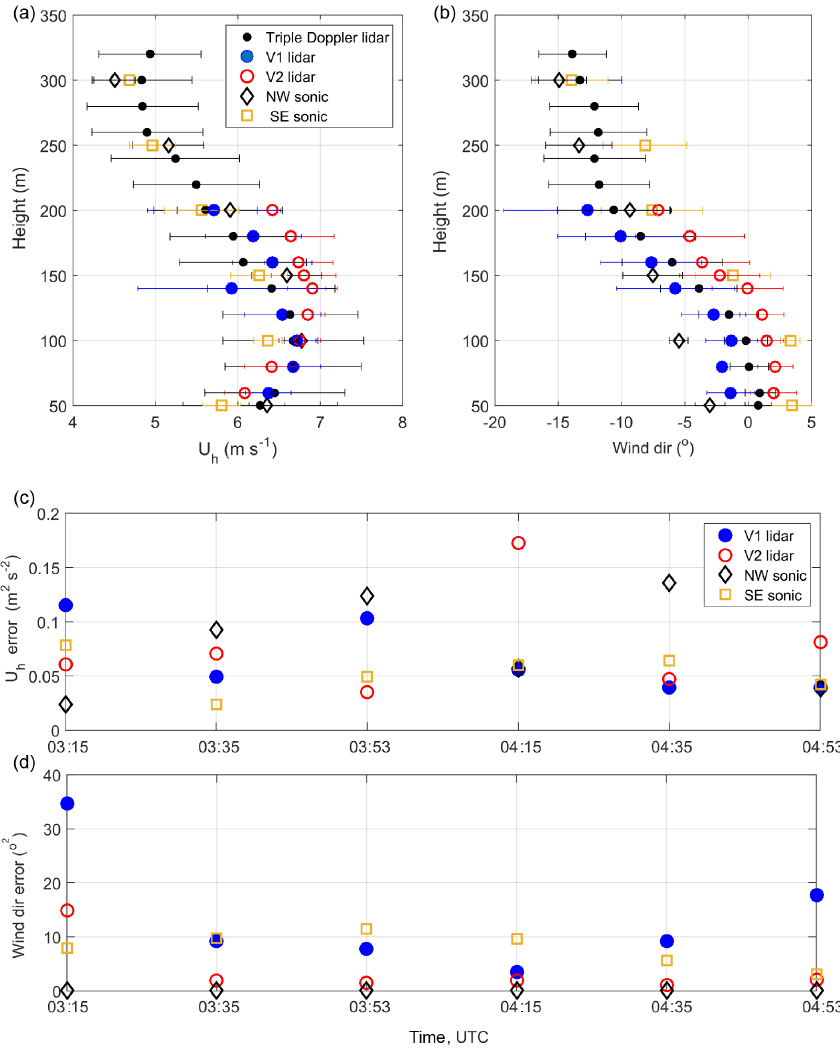
Figure 9. Time-averaged velocity profiles and error analysis: (a) average in-plane velocity, U h , for the time period 04:10–04:20 UTC; (b) average wind direction for the time period 04:10–04:20UTC; (c) error in U h for the different time-averaged vertical profiles; (d) error in wind direction for the different time-averaged vertical